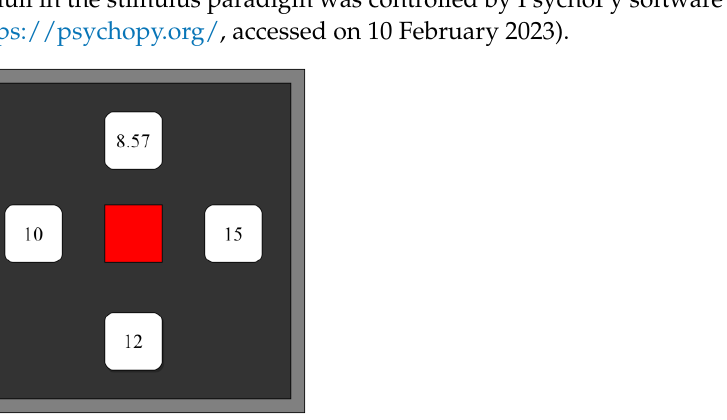
Figure 1. The distribution of the four stimulus targets on the graphical user interface is shown. Each stimulus target has a different frequency.